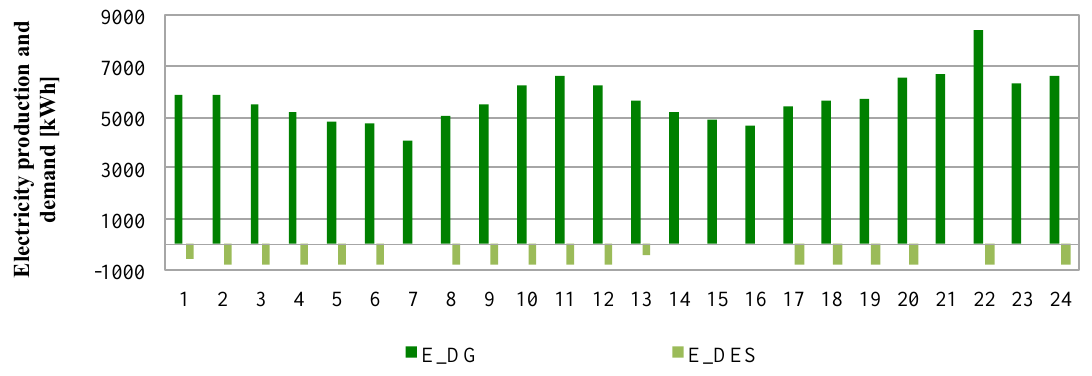
Figure 11. Optimal daily schedule of diesel generators and desalination units in August (maximum load month) in the TO-BE scenario 1. In this figure E_DG is the variable E DG and E_DES is the variable E DES.